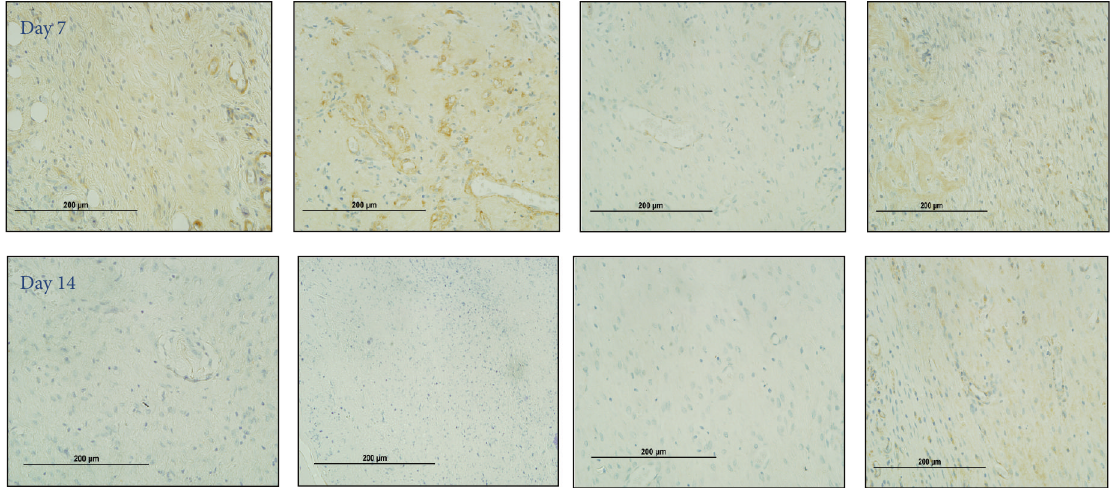
Figure 4: Wound collagen IV staining images. Representative images reflect that collagen IV is increased at day 14 in CTGF treated diabetic rodent wounds relative to the other groups and remained at a level similar to that observed at day